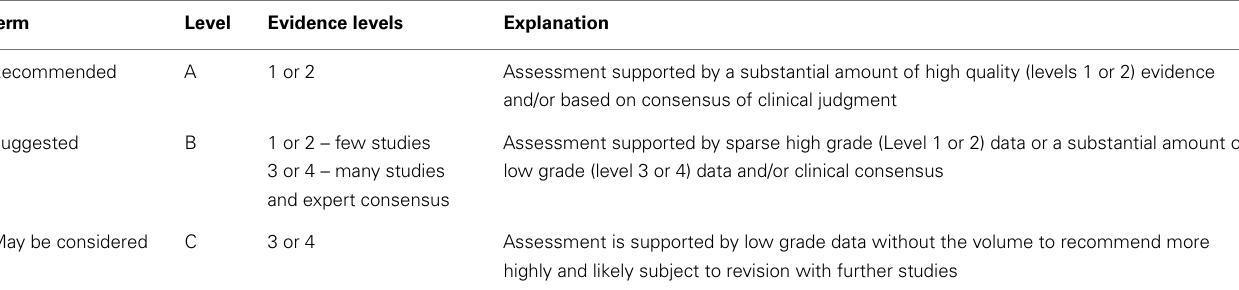
Table 4 |Table showing levels of